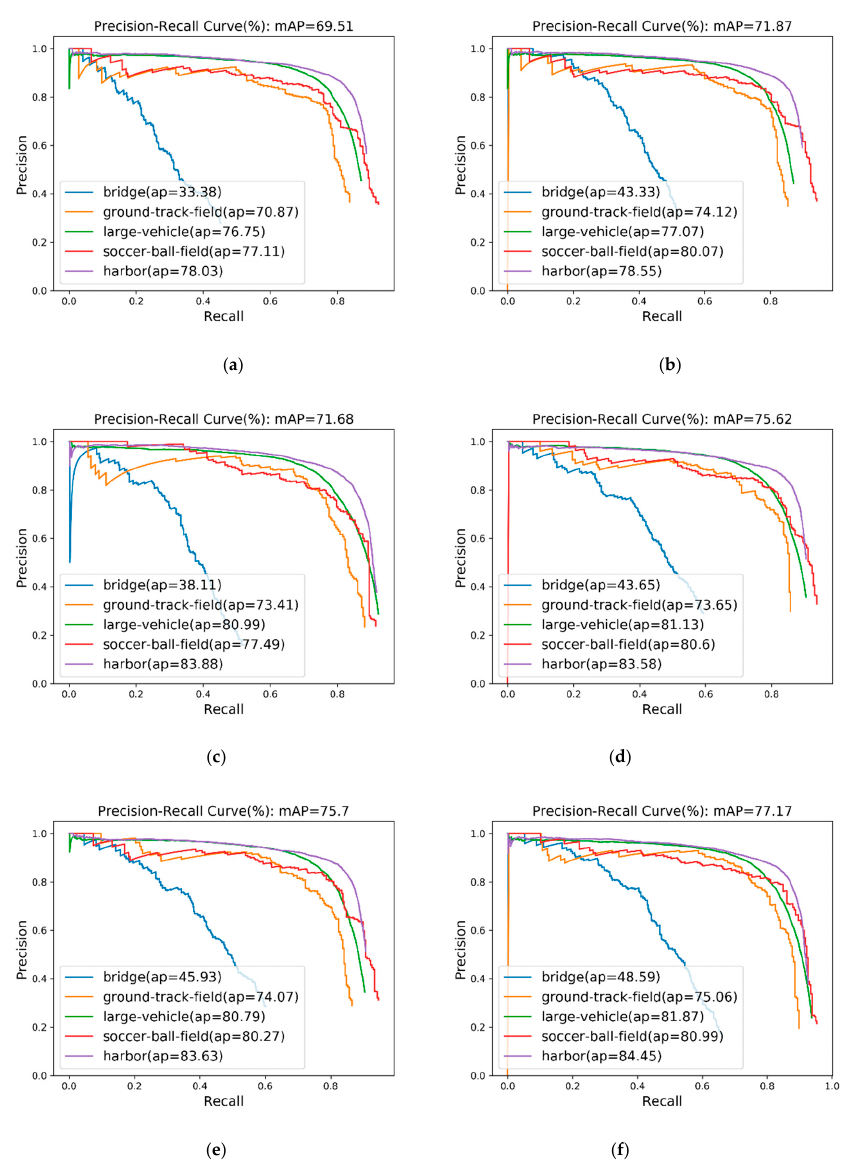
Figure 7. The precision-recall curves of Table 4: ( a ) FPN. ( b ) FPN + AS: FPN with the adaptive scale training strategy. ( c ) FPN + AA: FPN with the adaptive anchors. ( d ) EFPN + AS: EFPN with the adaptive scale training strategy. ( e ) EFPN + AA: EFPN with the adaptive anchors. ( f ) EFPN++: FPN with the adaptive scale training strategy and adaptive anchors.